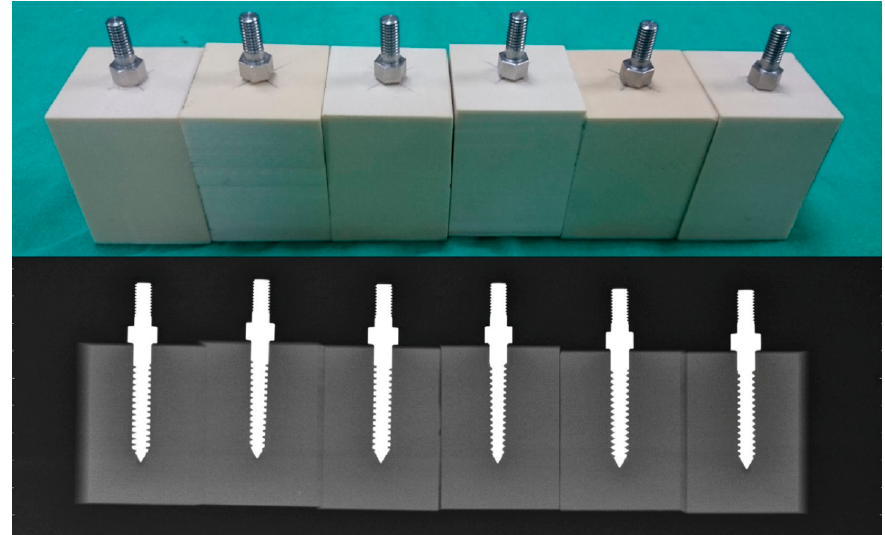
Figure 3. Photographs (upper) and radiological images (bottom) of the test blocks after the insertion of screws with various geometries. The inserted screws from left to right are Cy/Co-S, Co/Co-S, Cy/Cy-S, Co/Co-V, Cy/Co-V and Cy/Cy-V, respectively.